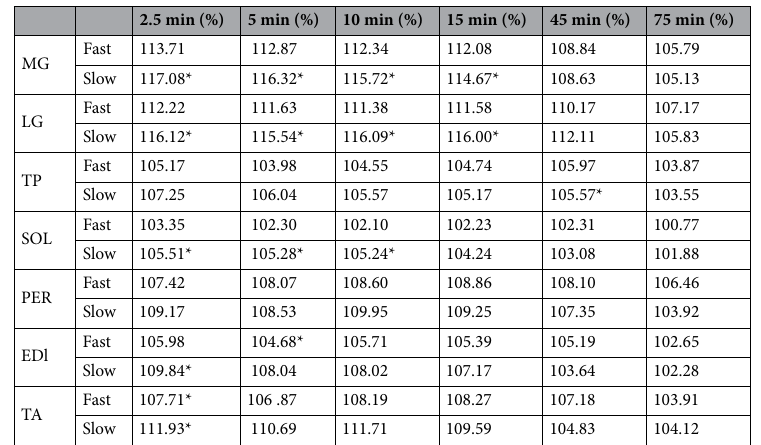
Table 3. Relative changes for fast and slow runners. The initial increase is lower for the fast runners. At the same time, however, there is also a smaller drop in the later running phases. * marking significant difference ( p < 0.05) compared to 75 min timepoint (* after diagonal